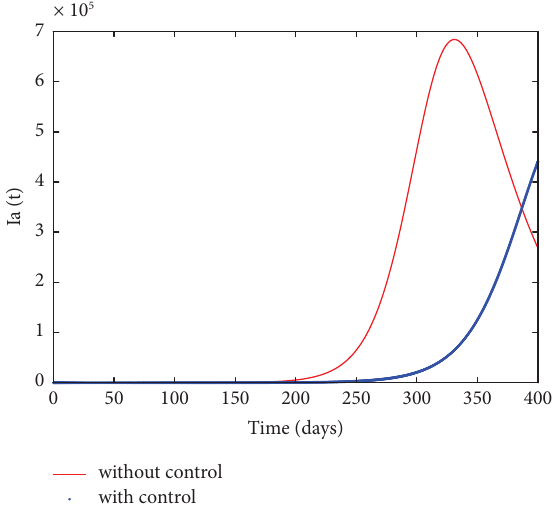
Figure 11: Behaviour of the asymptomatic individuals with and without the control.